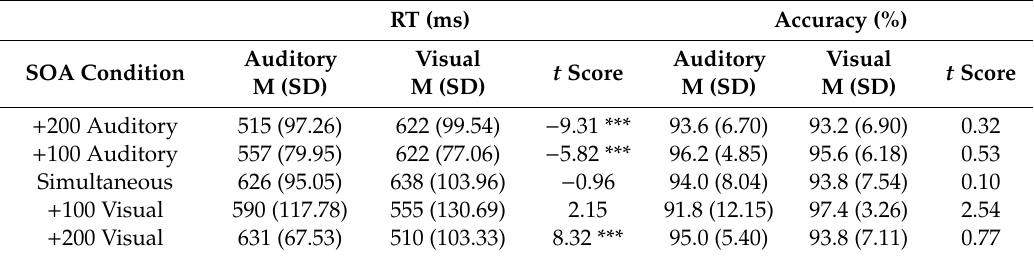
Table 2. Reaction times and accuracy scores in the 1-button task. Means, standard deviations, and t statistics from pairwise comparisons of auditory and visual oddballs. RT (ms) Accuracy (%) SOA Condition